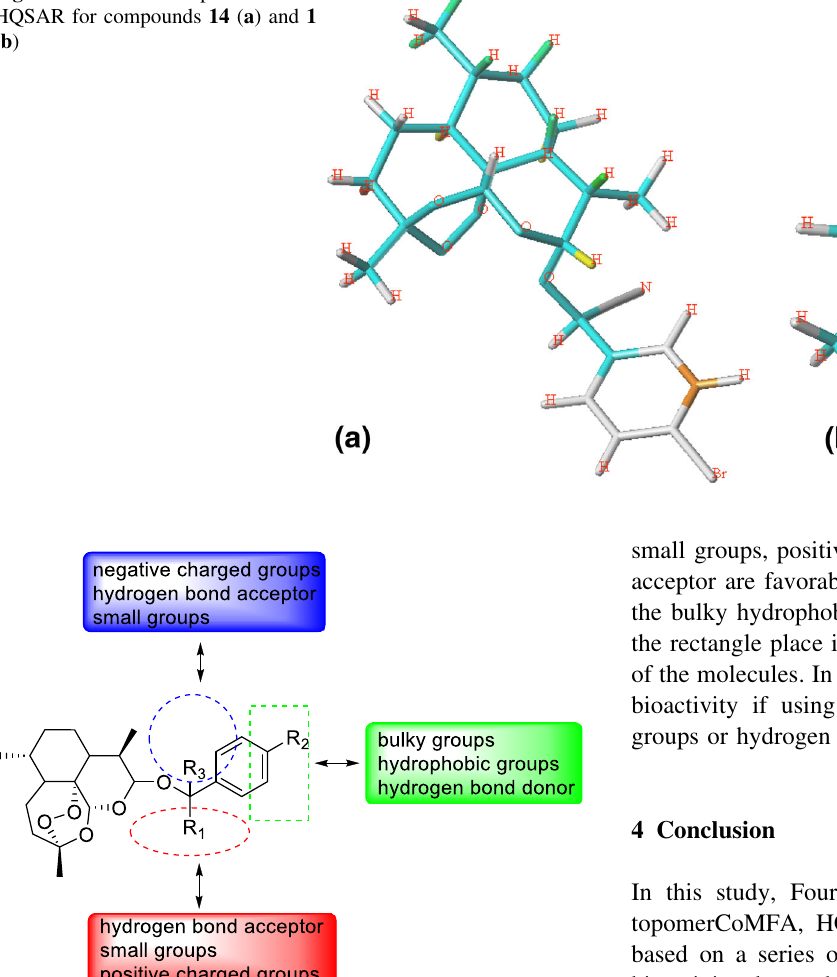
Fig. 5 Contribution maps from